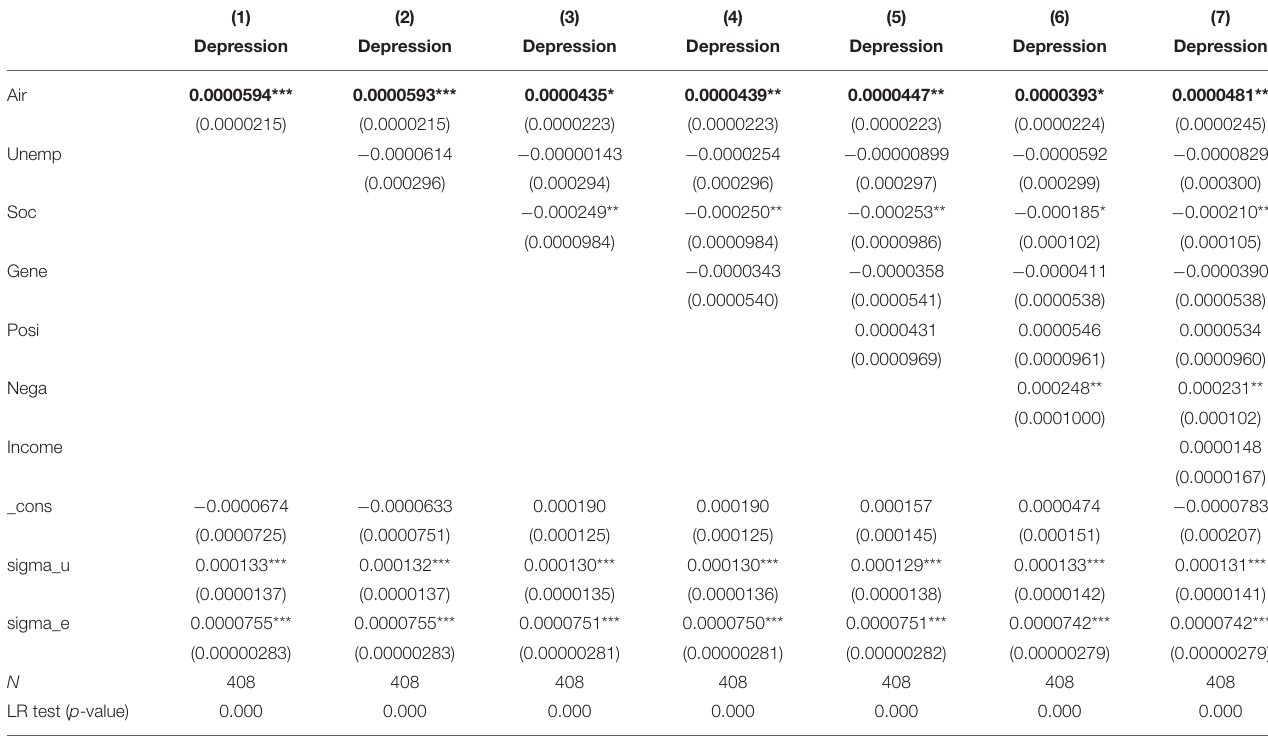
TABLE 5 | Regression results of air pollution on depression under complete